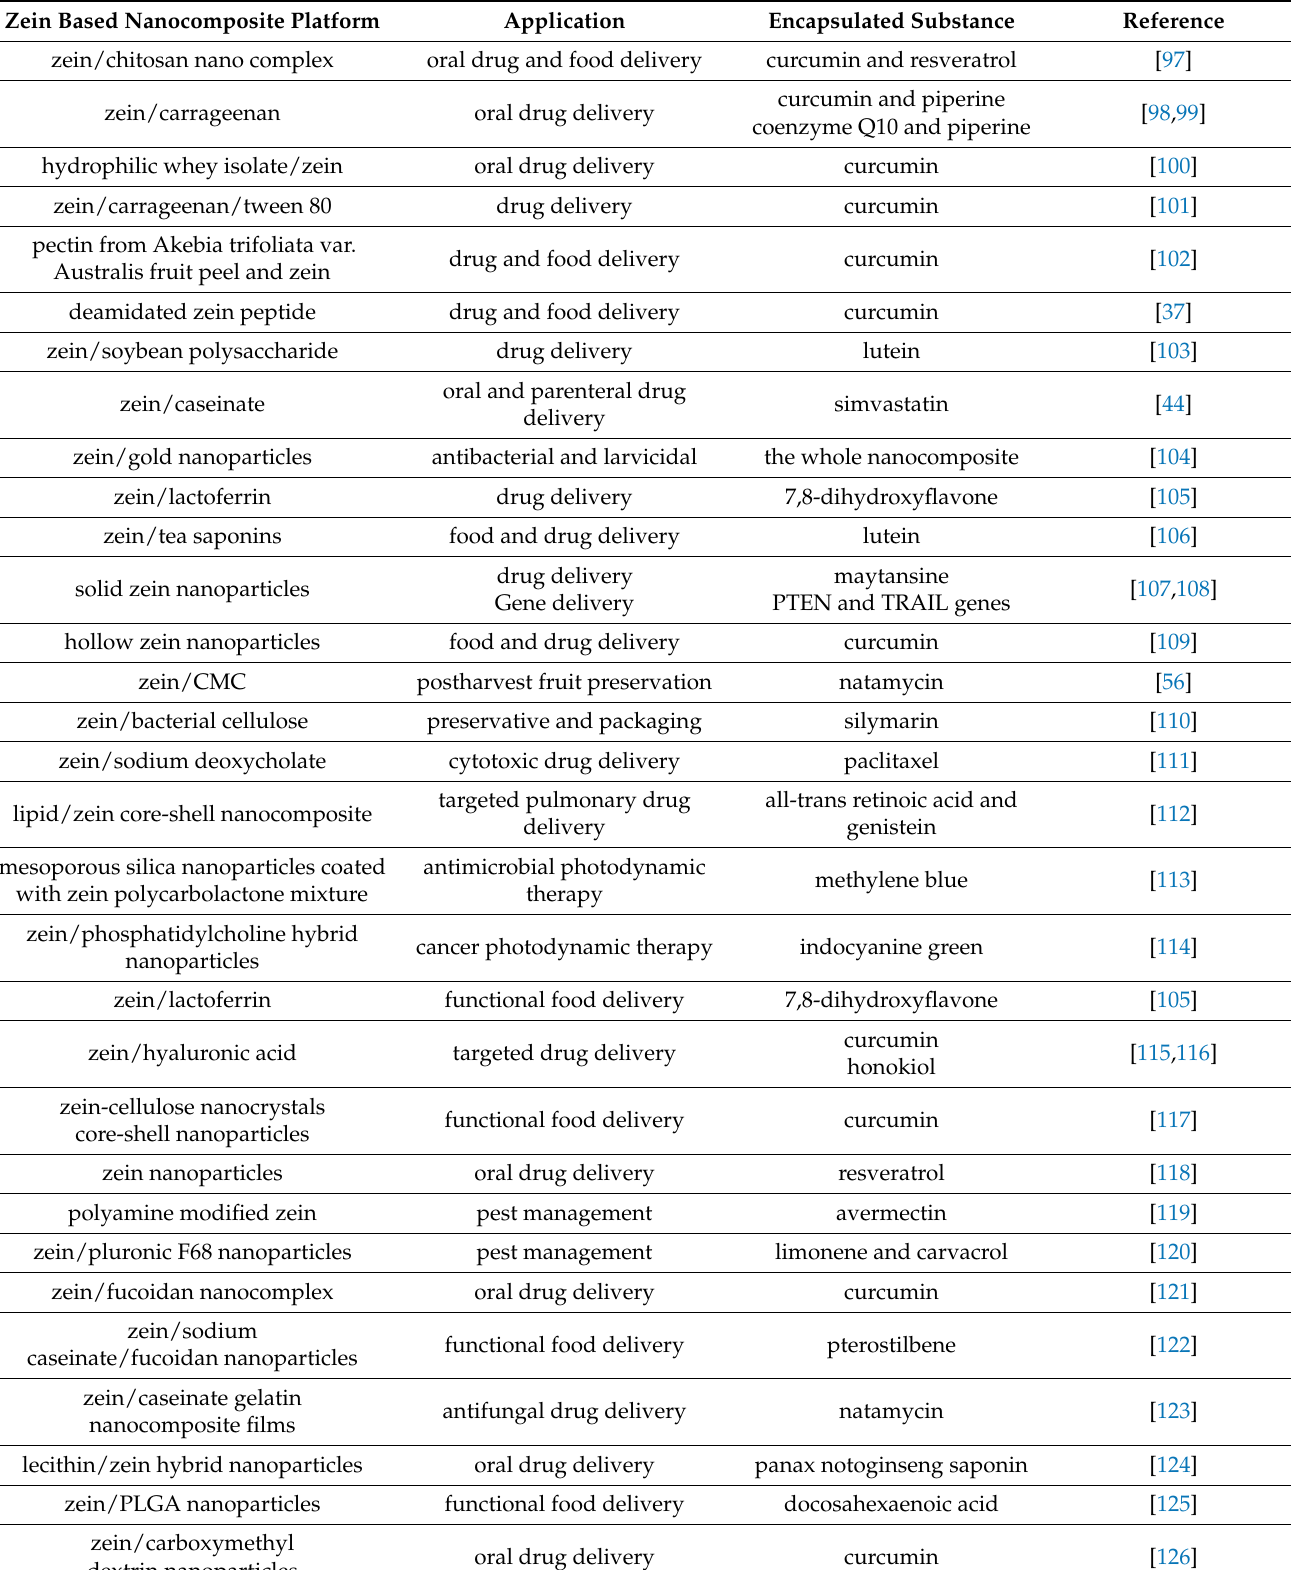
Table 2. Different applications of zein-based systems presented in recent